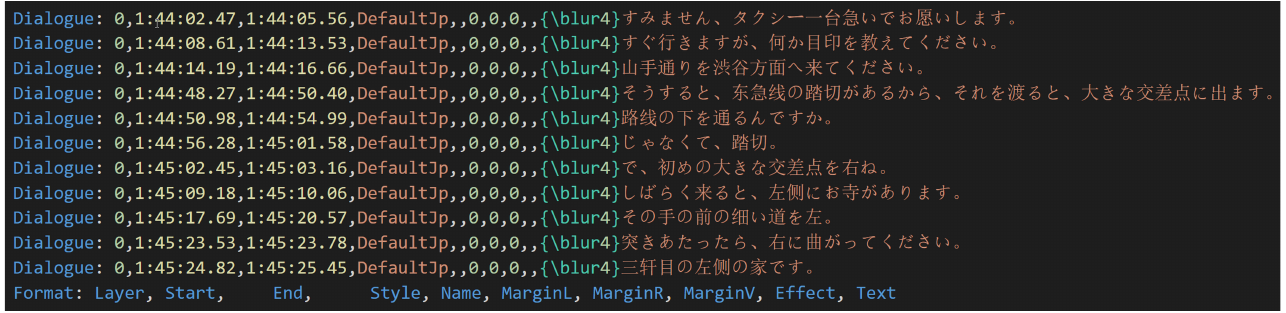
Figure 1. An example of the contents of an ASS file (dummy content, the main story is about a conversation asking for the